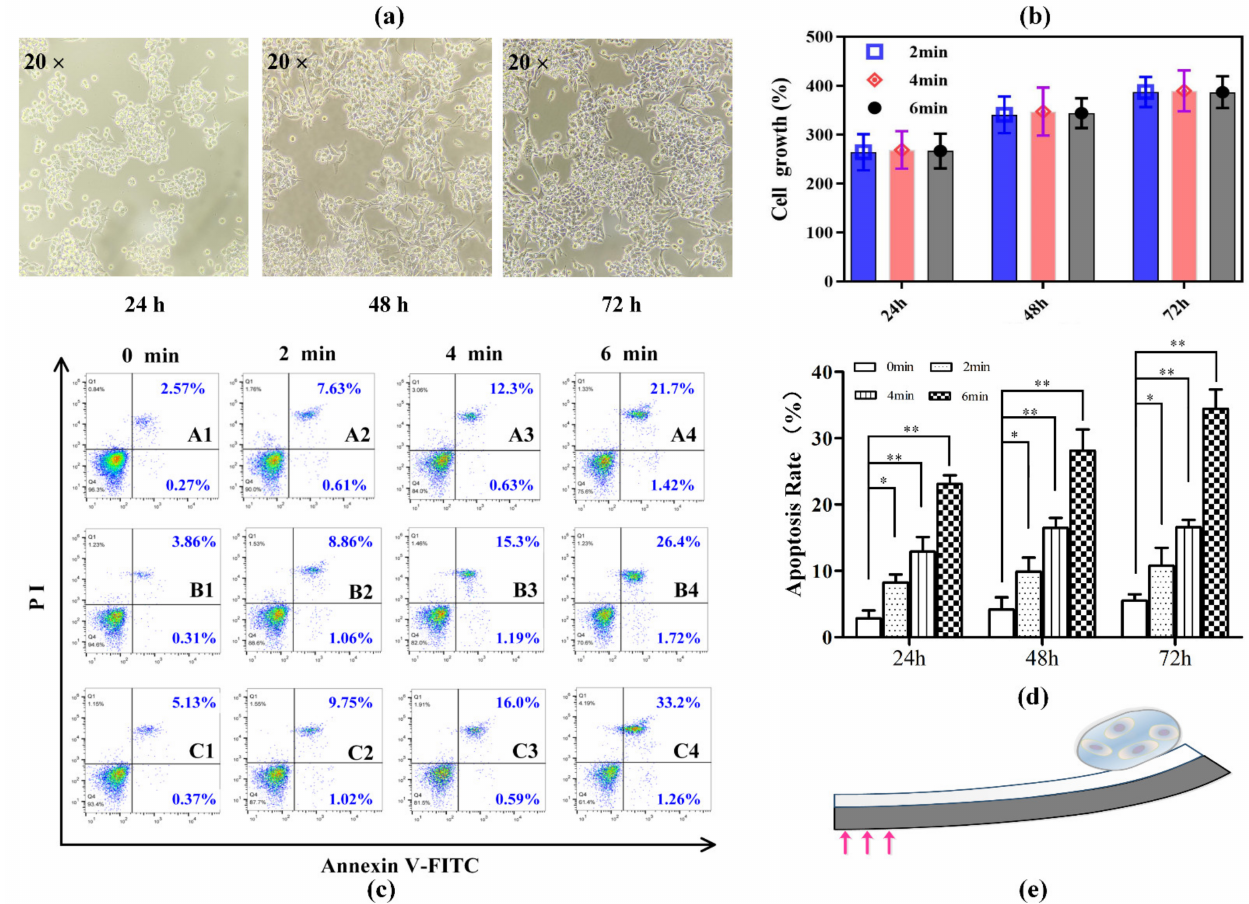
Figure 7. Photomechanical actuation induced MNK-45 cell mechanical responses. ( a ) Normal MKN- 45 cell growth morphologies without mechanical stimulation after being cultured for 24, 48, and 72 h. ( b ) Growth rates of normal MKN-45 cells without mechanical stimulation. They were set as the control group. ( c ) Flow cytometry analysis of apoptosis with annexin-V/PI staining. A1–A4: MKN-45 cells were mechanically stimulated with 0, 2, 4, and 6 min for 24 h. B1–B4: MKN-45 cells were treated with 0, 2, 4, and 6 min for 48 h. C1–C4: MKN-45 cells were treated with 0, 2, 4, and 6 min for 72 h. Cells stained with PI were considered as dead cells. The lower left quadrant (annexin V and PI negative) represents viable cells; the lower right quadrant (annexin V positive and PI negative) represents apoptotic cells in the early stage; The upper right quadrant (annexin V and PI positive) represents late apoptotic or necrotic cells; the upper left quadrant (annexin V negative and PI positive) represents necrotic cells or cellular debris. Numbers refer to the percentage of annexin-V and/or PI-labeled cells. ( d ) Total apoptosis rate (early apoptosis rate + late apoptosis rate) comparisons between experimental groups. (* p ≤ 0.05, ** p ≤ 0.01). ( e ) Photomechanical-actuation-induced mechanical force loading diagram on cells in